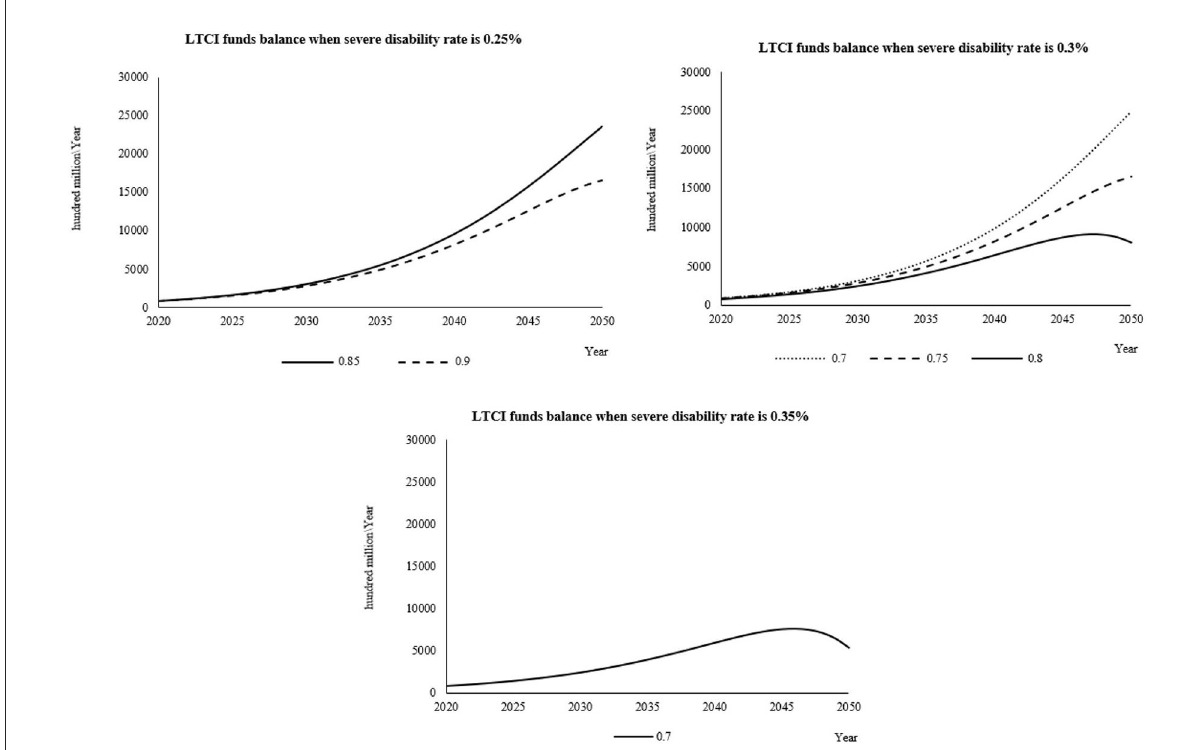
FIGURE3 When the individual payment rate is 0.09%, the fund balance changes in the reasonable financing scheme of LTCI under different severe disability rates.